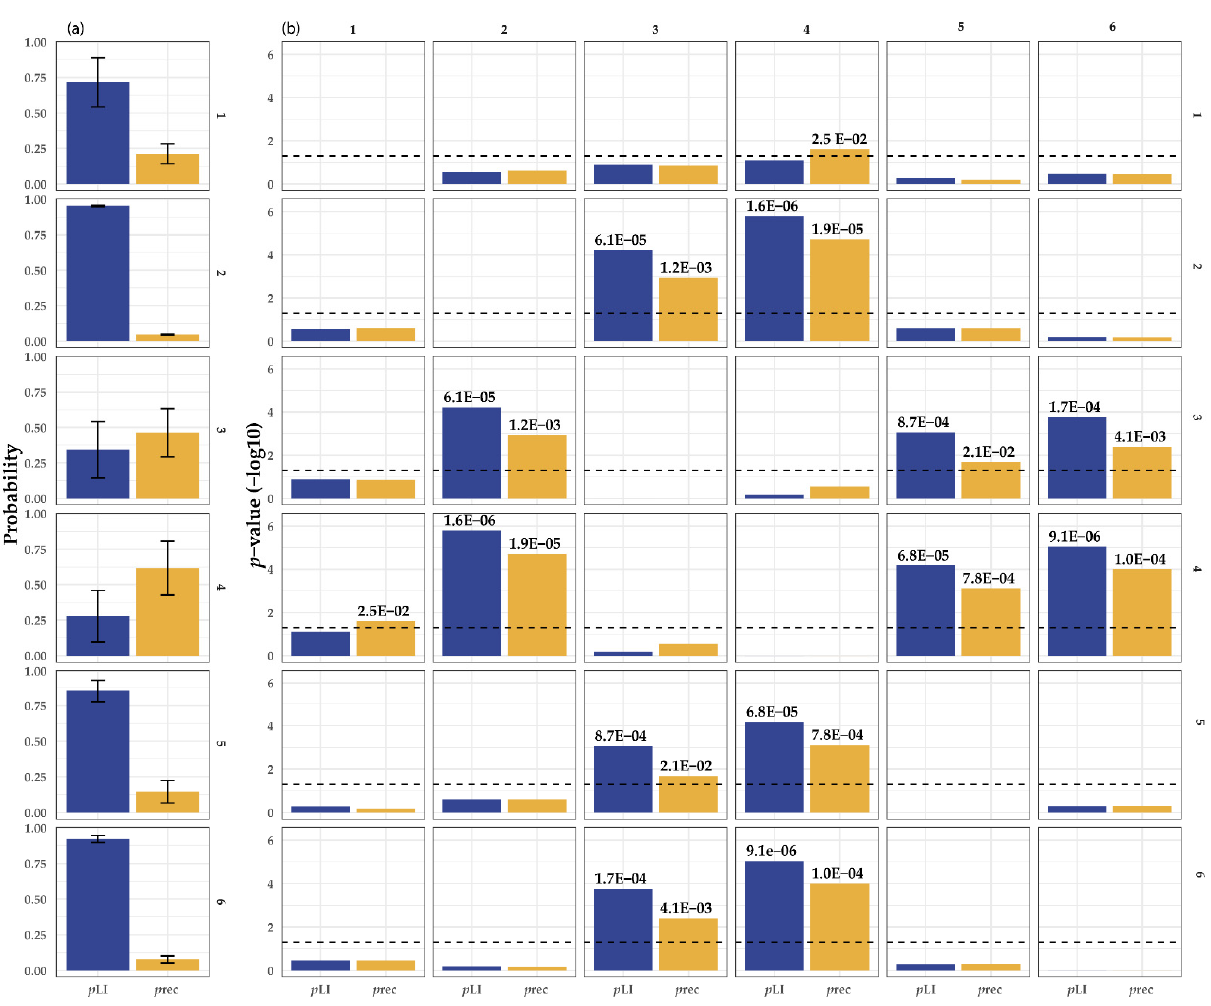
Figure 2. ( a ) Statistical comparison of the gene characteristics of OA/TOF-associated genes. Depicted are the average value and variance of the pRec score (orange) and PLI scores (blue, a) derived from https://gnomad.broadinstitute.org/, accessed on 2 July 2021. pRec; gene likely intolerant for recessive variation, pLI; gene likely intolerant for heterozygous loss of function variation. The right matrix depicts the six different groups and corresponding statistical evaluation of the differences in pLI and pRec scores of in vivo animal model and patient phenotype genes: 1, human patients and animal models with EA and or TOF; 2, human patients with OA/TOF and animal models with foregut anomalies; 3, human patients with OA/TOF and animal model with lethal mutations; 4, no human patients but animal models with OA/TOF; 5, animal models with foregut anomalies but no human patients described; and 6, human patients described but animal models with no phenotype. ( b ) The characteristics (see Table 1) are compared using an univariate test and T-statistics. For readability, E depicts the scientific E notation for × 10 − a